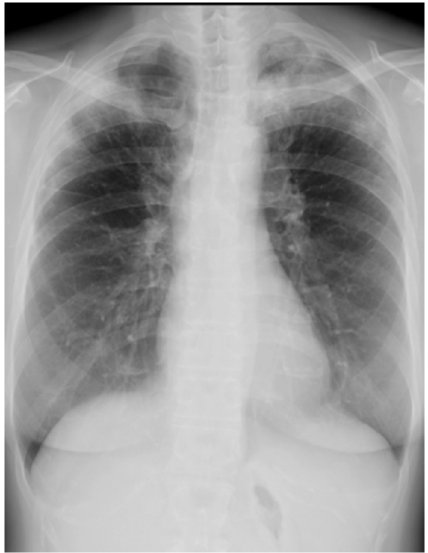
Figure 1. Chest X-ray of 55-year-old woman upon admission with fever and dyspnea. It showed bilateral consolidation in her upper lung fields. On day 4 of hospitalization, bronchoscopy was performed, followed by bronchoalve- olar lavage and a random transbronchial lung biopsy. Blood cell fractionation of the bronchoalveolar lavage fluid showed neutrophils (25.0%), eosinophils (25.5%), lympho- cytes (32.5%), and monocytes (5.0%). Histopathological findings were consistent